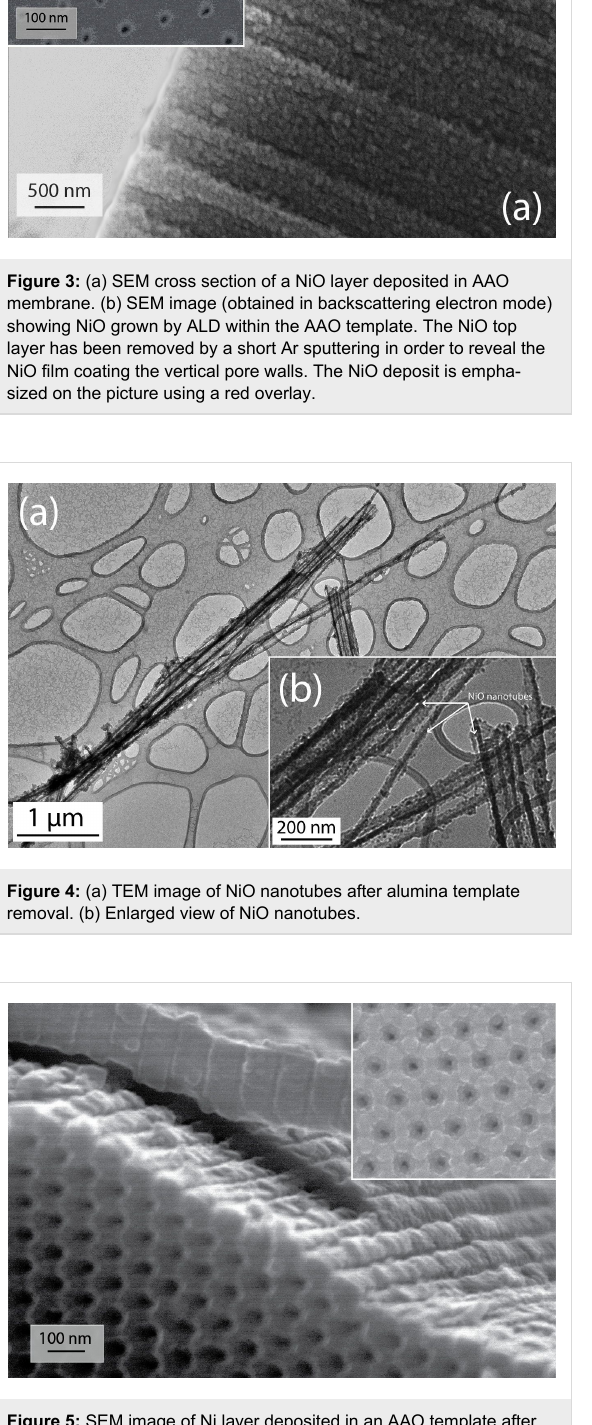
Figure 5: SEM image of Ni layer deposited in an AAO template after 3 h annealing in H 2 at 300 °C of the initially deposited NiO by ALD. The inset shows a detailed top-view of the